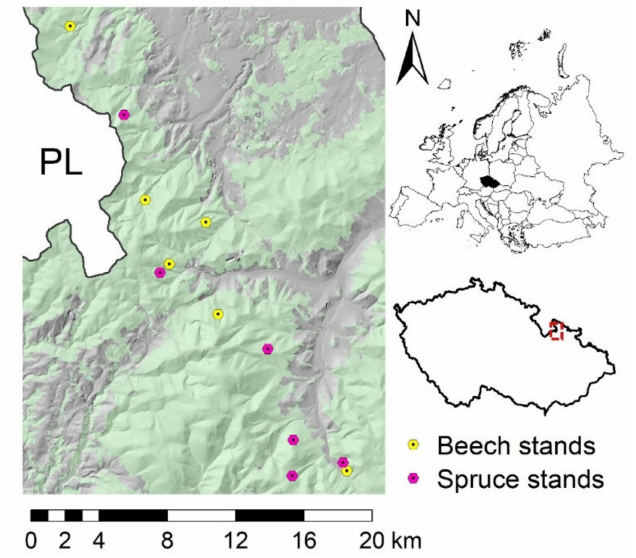
Figure 1. Study area with the sampling sites at the background layer derived from the regional forest development plans (forest areas are green); the digital model of the Czech Republic was used for shading; PL =